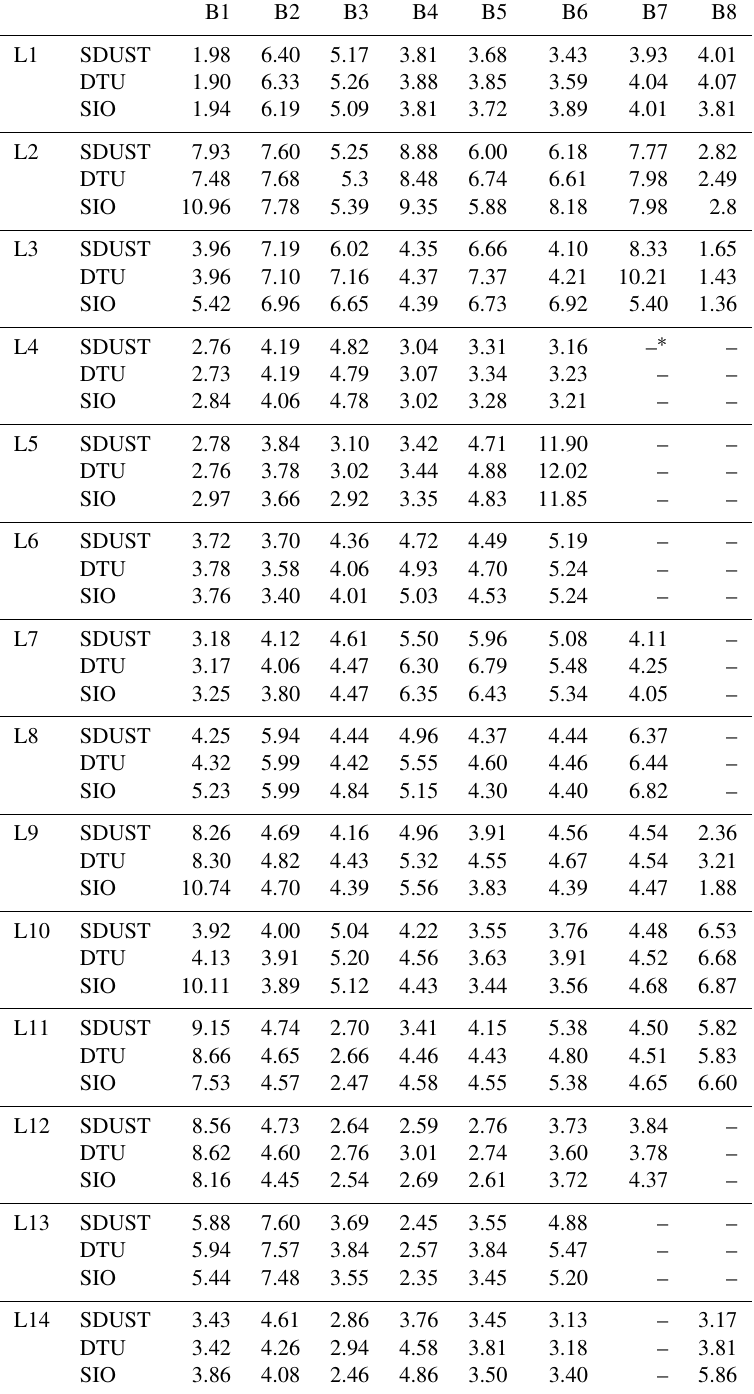
Table A1. RMSE of differences between altimeter-derived and shipborne gravity data